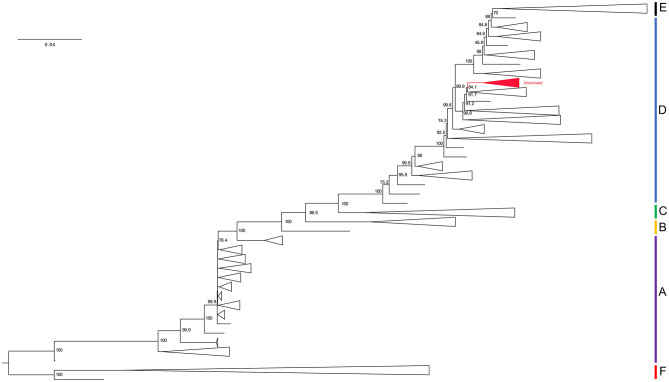
Phylogenetic hypothesis of dataset 1.1. Maximum-likelihood tree. Branch lengths represent an estimation of the average number of nucleotide substitutions per site. Node labels indicate SH-aLRT support. Clade names correlate to their genotype assignment and are represented by the vertical bars on the right of the tree. Red collapsed clade represents the Greenland taxa. See Supplementary Material for a full version of this tree.